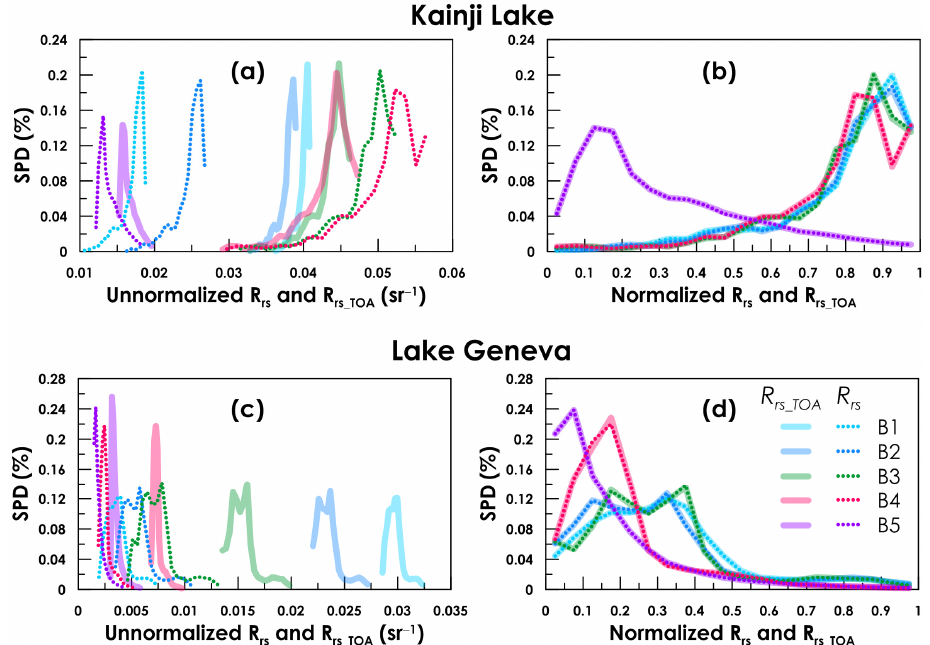
Figure 2. Normalized and unnormalized R rs and R rs_TOA of Lake Geneva and Kainji Lake: ( a , c ) un- normalized R rs and R rs_TOA and ( b , d ) normalized R rs and R rs_TOA .